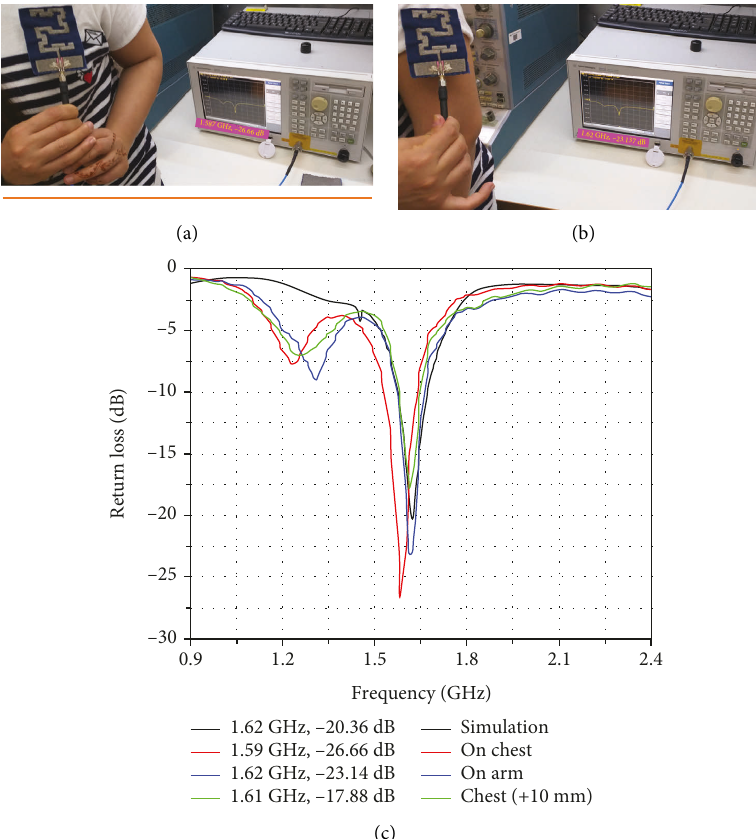
Figure 11: (a) Fabricated textile antenna placed on the chest, (b) conformal on the human arm for experimental study of the body’s effect on antenna performance, and (c) return loss versus frequency